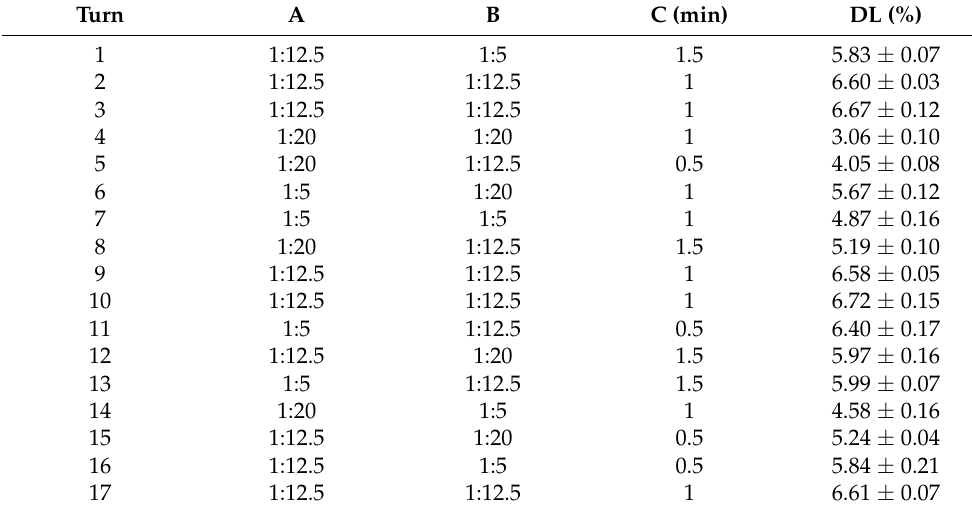
Table 6. The Box–Behnken screening design matrix and